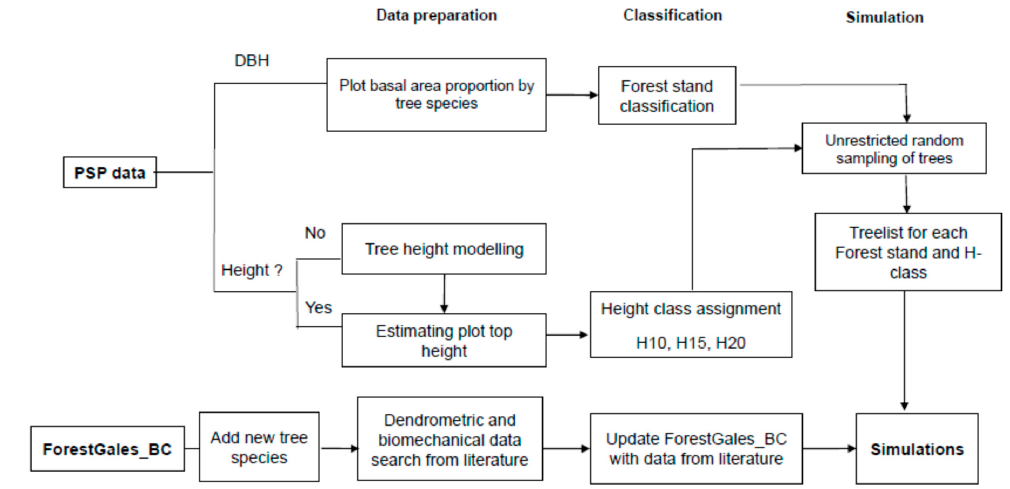
Figure 1. A schematic framework of the study methodological stages. H10, H15, H20 corresponds to height classes 10 m, 15 m, 20 m, respectively. PSP, permanent sample plot; DBH, diameter at breast height.